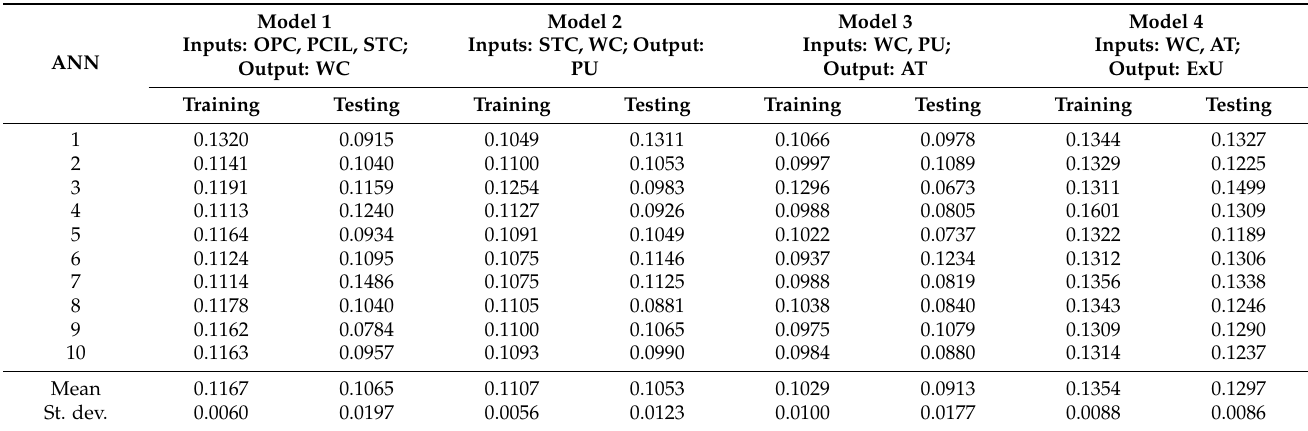
Figure 5. An example of an ANN model—Model 1. Table 10. RMSE values of ANN